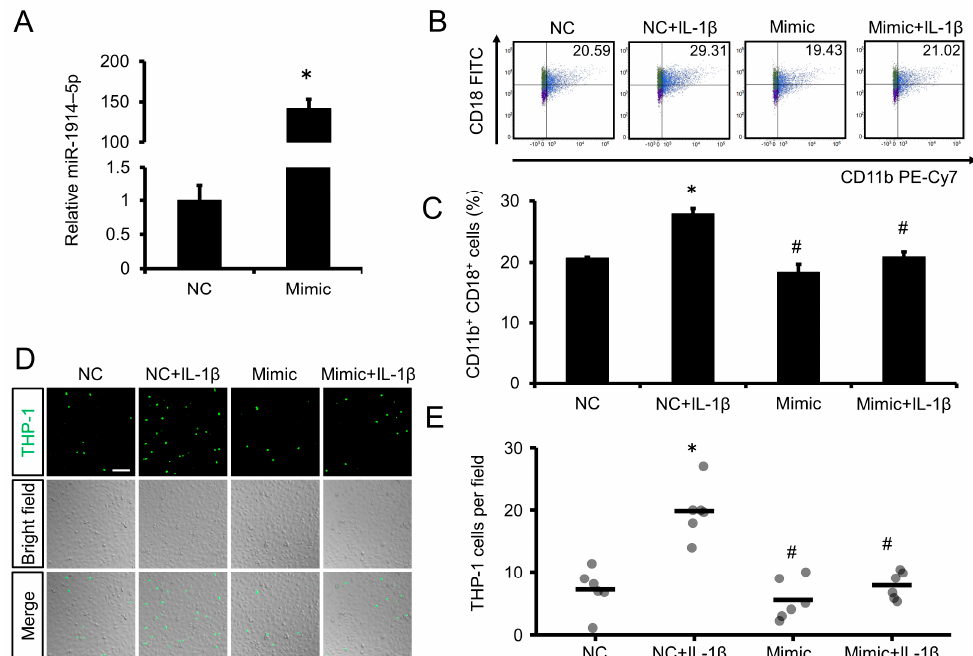
Figure 4. Effect of miR-1914-5p mimic on IL-1 β –induced adhesion of monocytes to endothelial cells. ( A ) THP-1 cells were transfected with miR-1914-5p mimic or NC mimic for 24 h. miR-1914-5p levels were then assessed by qRT-PCR. Compared with the NC, the mimic of miR-1914-5p significantly increased miR-1914-5p expression in THP-1 cells. n = 3 per group. * p < 0.05 compared with the NC transfected group. ( B ) THP-1 cells were transfected with miR-1914-5p mimic or NC for 24 h and then incubated with IL-1 β for 24 h. After 24 h of IL-1 β treatment, Mac-1 expression in THP-1 cells was examined by flow cytometry. THP-1 cells expressing Mac-1 were defined as CD11b + , CD18 + cells. ( C ) Proportion of cells expressing Mac-1 (CD11b + , CD18 + cells) among live cells. n = 3 in each group. * p < 0.05 compared with the NC group. # p < 0.05 compared with the NC+IL-1 β group. ( D ) Adhesion of THP-1 cells to an EA.hy926 cell monolayer. THP-1 cells and EA.hy926 cells were co-cultured for 1 h after transfection and IL-1 β exposure. Scale bar represents 100 µ m. ( E ) The number of fluorescent THP-1 monocytes on the EA.hy926 cell monolayer was determined. n = 6 fields in each group. * p < 0.05 compared with the NC group. # p < 0.05 compared with the NC+IL-1 β group.